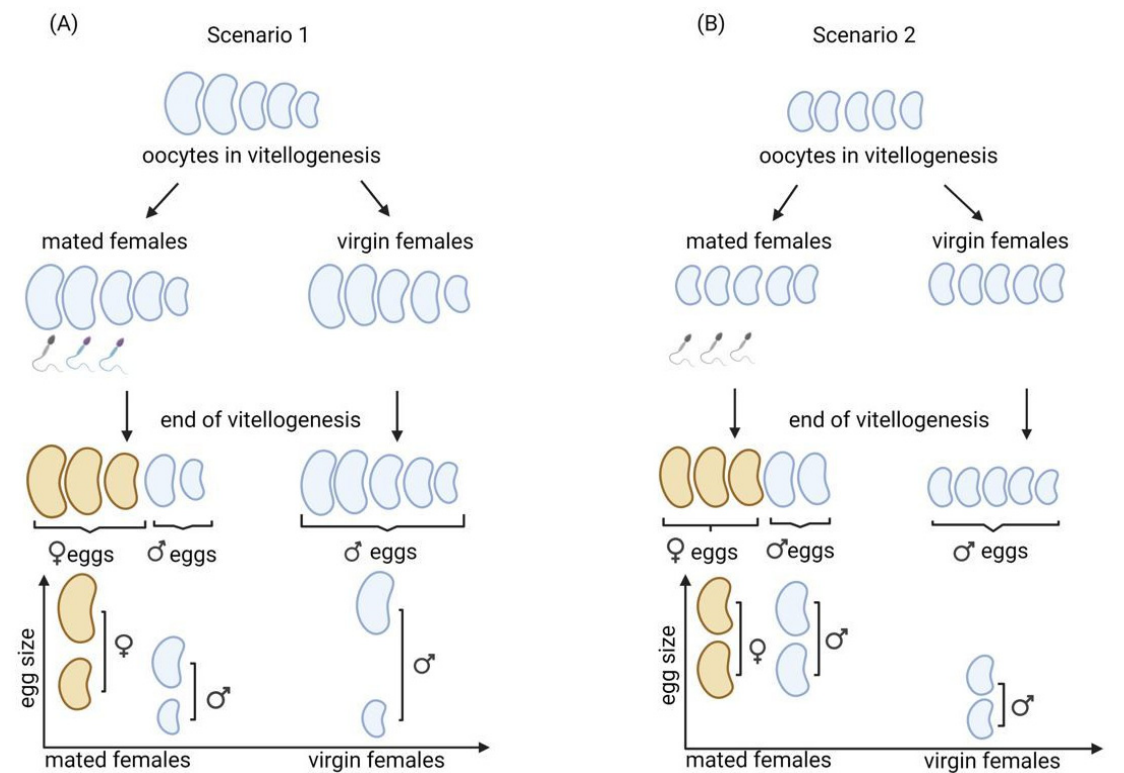
Figure 2. Hypothetical mechanisms of sex-specific egg size in haplodiploid arrhenotokous lineages of T. tabaci . ( A ) Scenario 1: Differences in egg size exist before fertilization, and egg size determines the probability of an egg being fertilized. Under this scenario, the egg size range between virgin and mated mothers should be the same. ( B ) Scenario 2: Egg size is equal in virgin and mated mothers prior to fertilization, and mating increases the egg size in general. Straight vertical lines represent egg size ranges. Fertilized and unfertilized eggs are presented in brown and blue, respectively.